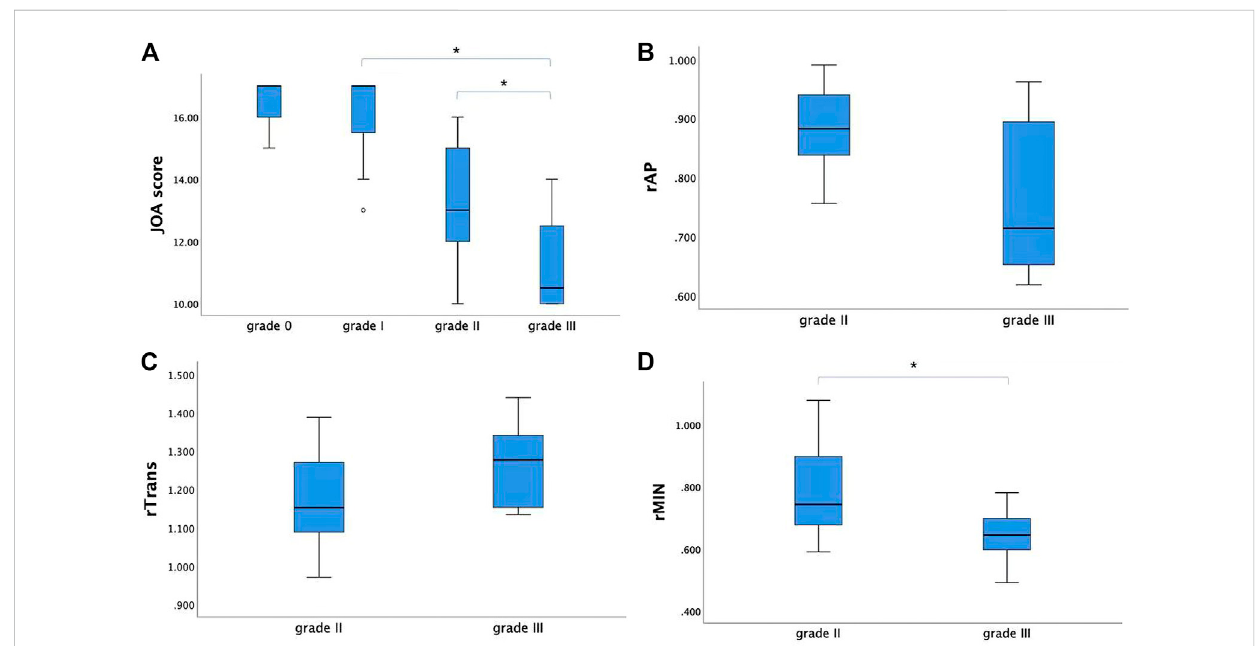
FIGURE 5 Association between clinicalscore,MAGICquantitative values (T1,T2),and diameter values ofthespinal cordatMCLingrade IIandgrade IIIgroups. (A) T2 MCL value was negatively correlated with rMIN. (B) T2 MCL value was positively correlated with rTrans. (C, D) T1 MCL and T2 MCL value all negatively correlated with JOA scores. (E, F) JOA score negatively correlated with rTrans, whereas positively correlated with